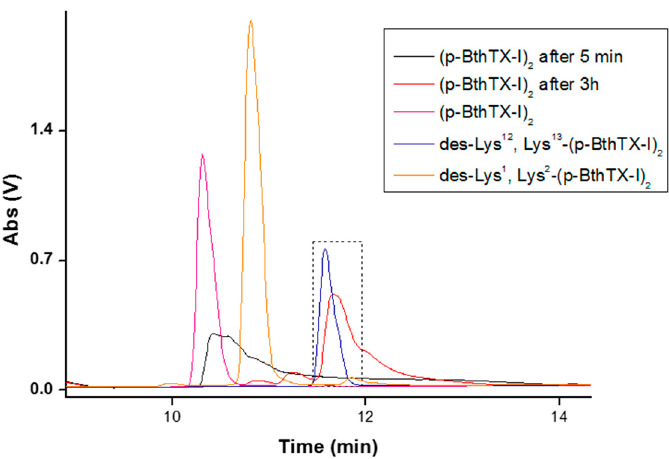
Figure 3. Analytical HPLC comparing the peaks of the peptides (p-BthTX-I) 2 , des-Lys 12 /Lys 13 -(p-BthTX-I) 2 , and des-Lys 1 /Lys 2 -(p-BthTX-I) 2 to the RT of peaks of the stable serum degradation product of (p-BthTX-I) 2 . Samples were eluted at 5 min and 3 h. Analytical HPLC was performed on a Shimadzu system using a C18 column (4.6 × 150 mm, Phenomenex) with a linear gradient of solvent B (5–95%) at 1 mL/min for 30 min (Solvent A: 0.045% trifluoroacetic acid (TFA) in water. Solvent B: 0.036% TFA in acetonitrile). Marked box indicates the peak of des-Lys 12 /Lys 13 -(p-BthTX-I) 2 and the stable degradation peptide produced. Table 2. Biological activities of the synthetic peptides.